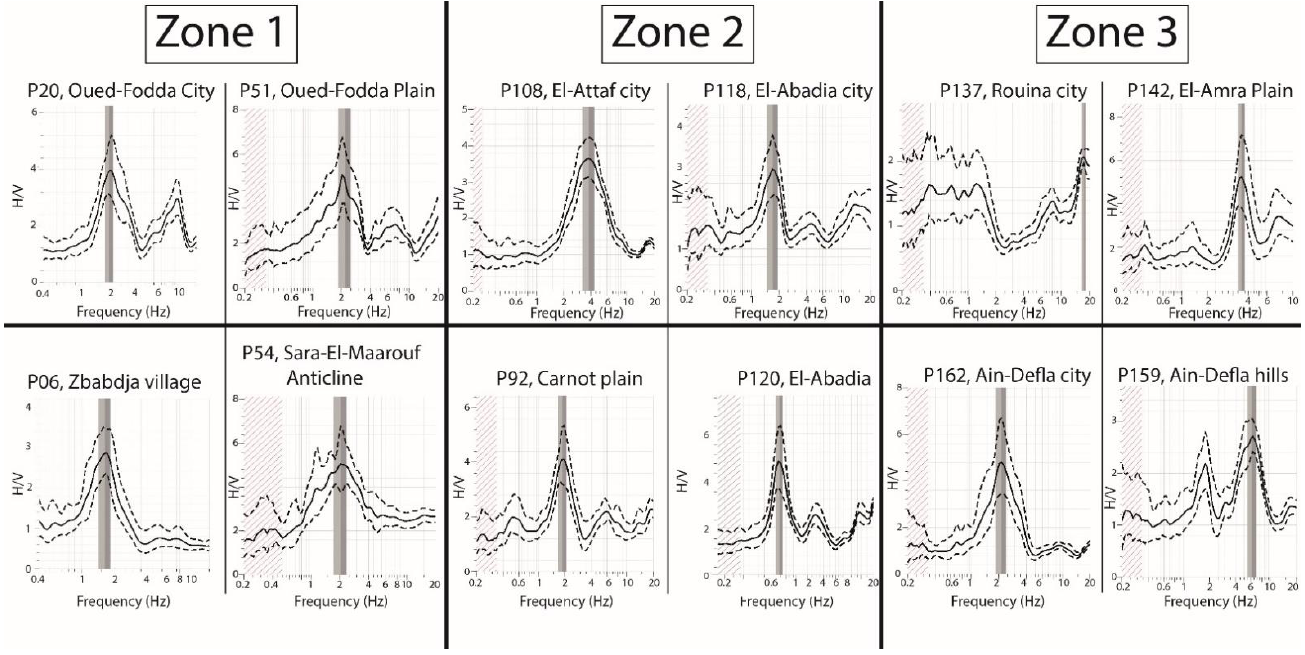
Figure 7. Some examples of the calculated HVSR curves at each